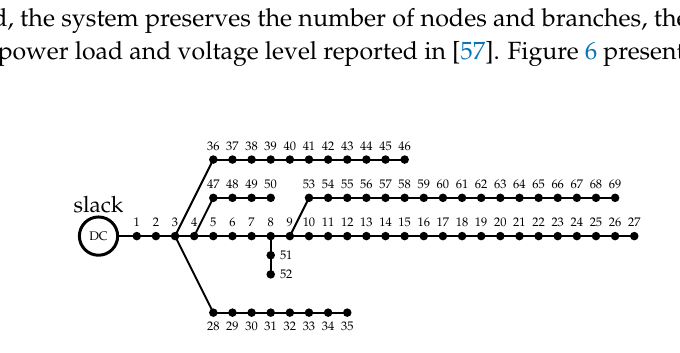
Figure 6. Line diagram the 69 bus test